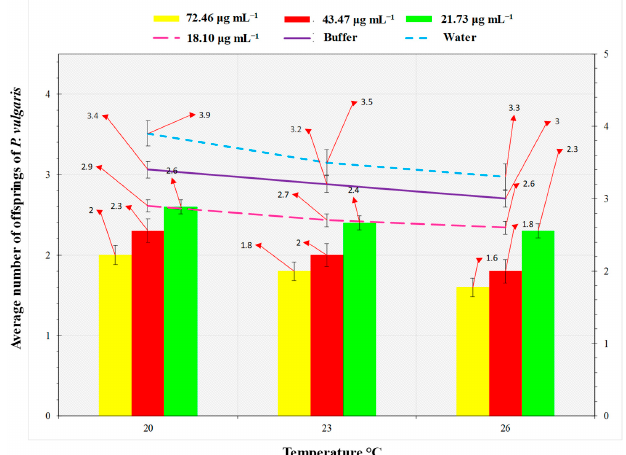
Figure 4. Phaseolus vulgaris average fecundity ( n = 10). Fecundity lessened in P. vulgaris seedlings treated with Hrip1, (one-way ANOVA with factorial analysis; LSD at alpha 0.05).